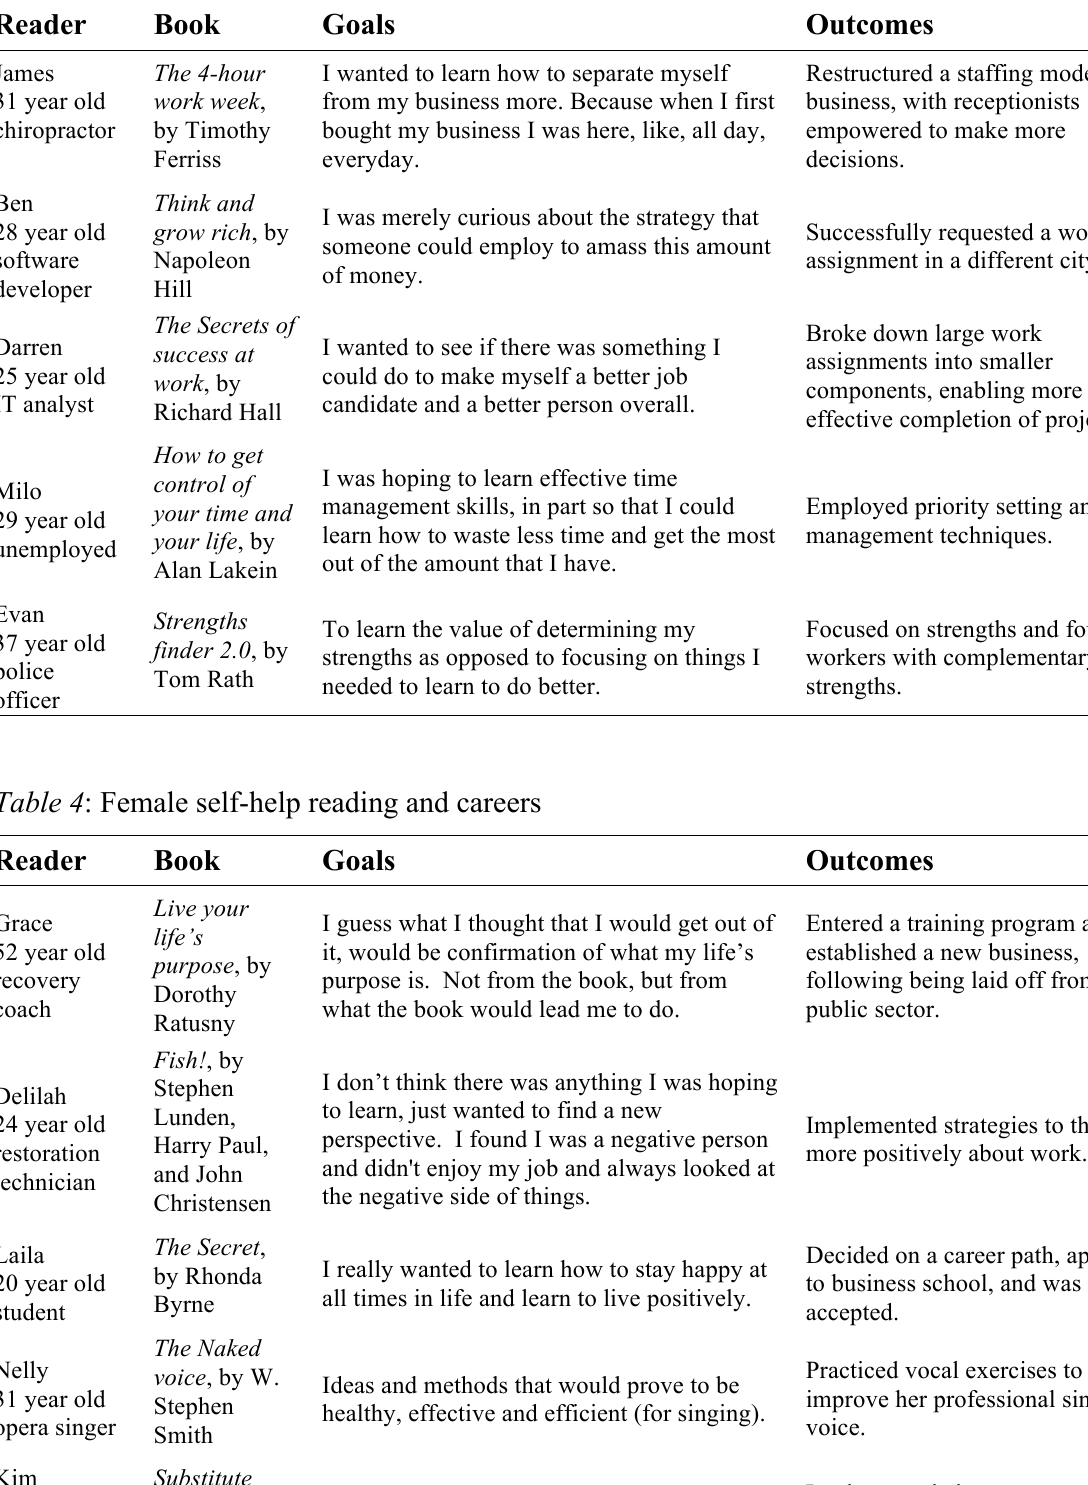
Table 3 : Male self-help reading and careers Reader